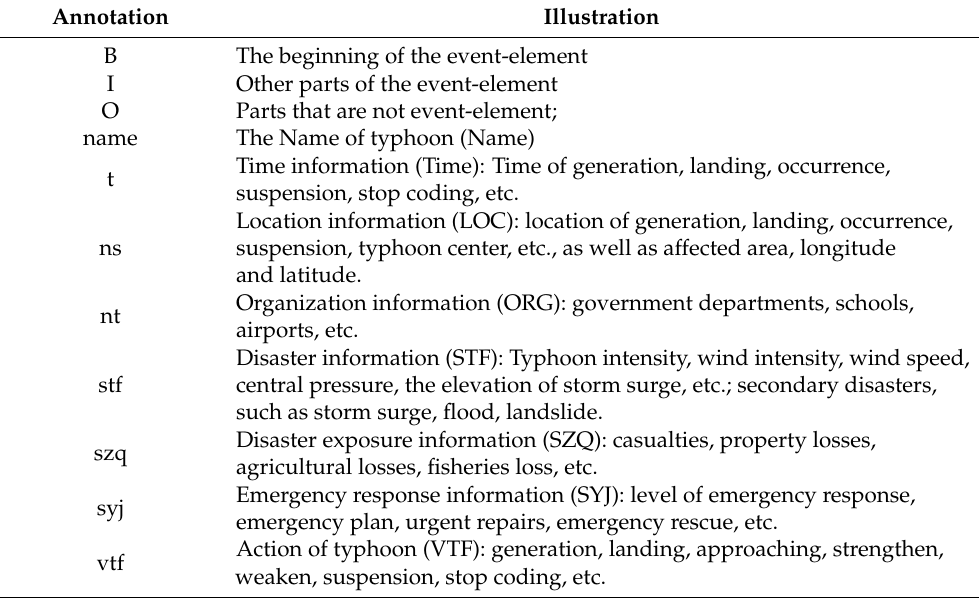
Table 1. The annotation set of typhoon event-elements.